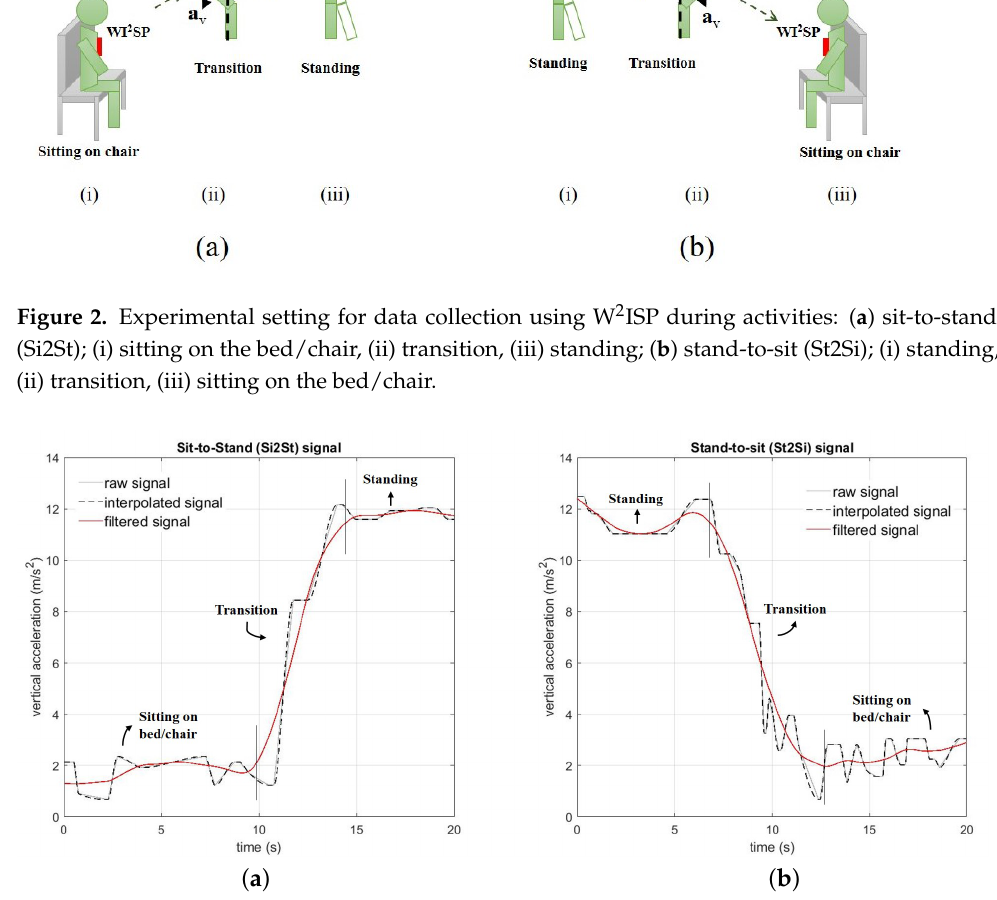
Figure 3. Raw, interpolated, and filtered vertical acceleration signal a v acquired from W 2 ISP while performing ( a ) Si2St and ( b )